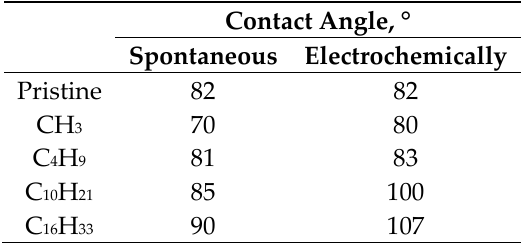
Table 2. Surface wettability (water contact angle) of pristine and grafted with ADTs gold